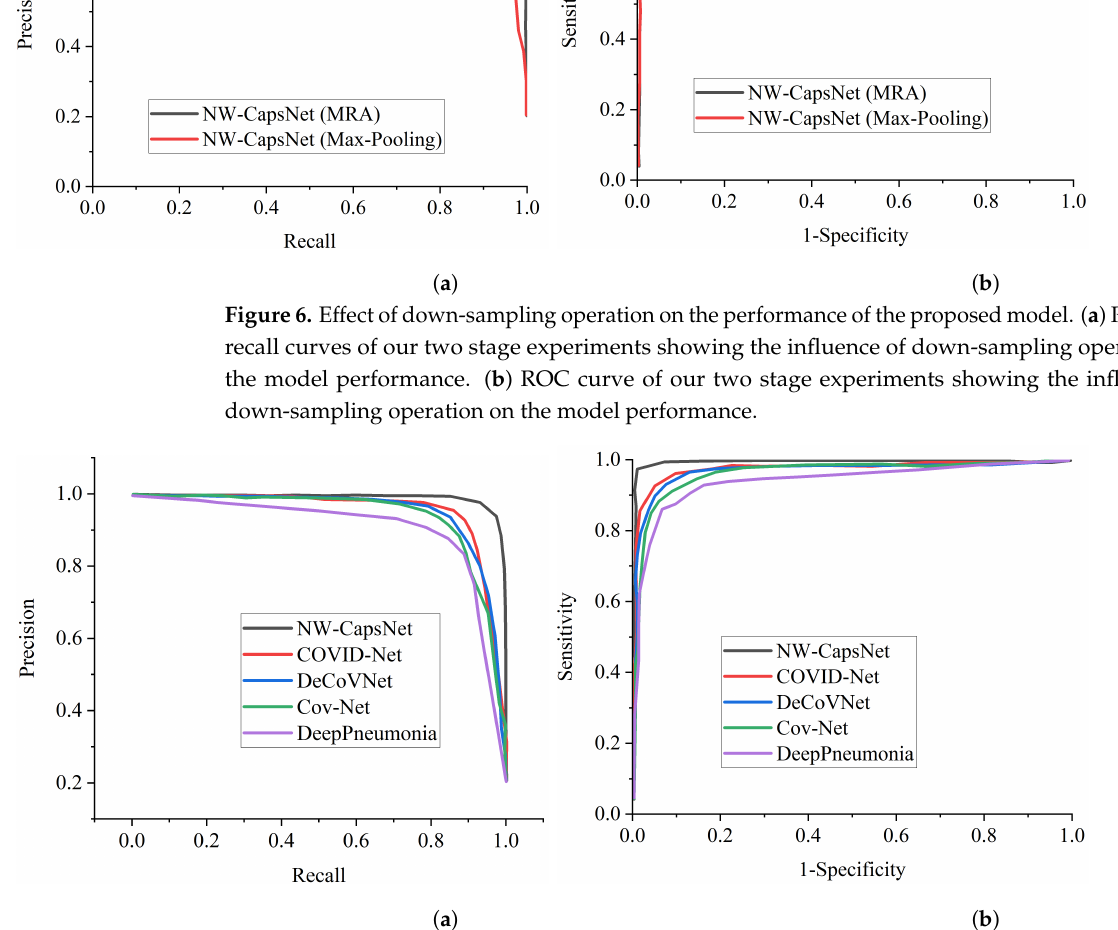
Figure 7. Performance comparison with state-of-the-art models. ( a ) Precision–recall curves of our pro- posed NW-CapsNet model in comparison to some state-of-the-art COVID-19 methods. ( b ) ROC curve of our proposed NW-CapsNet model in comparison to some state-of-the-art COVID-19